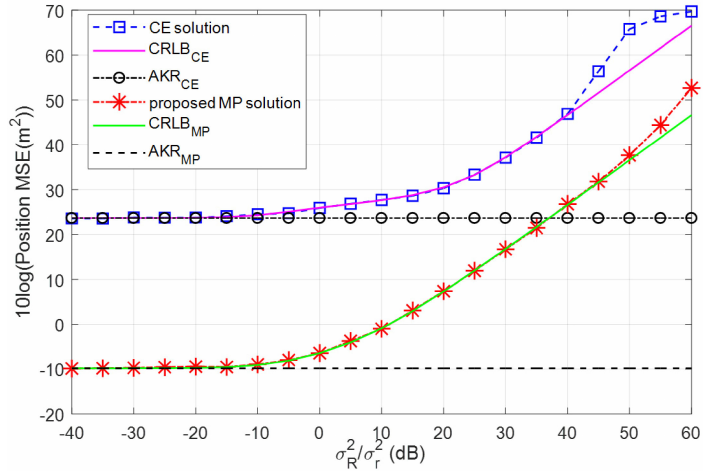
Figure 4. Performance of a far acoustic target and a far calibration source.